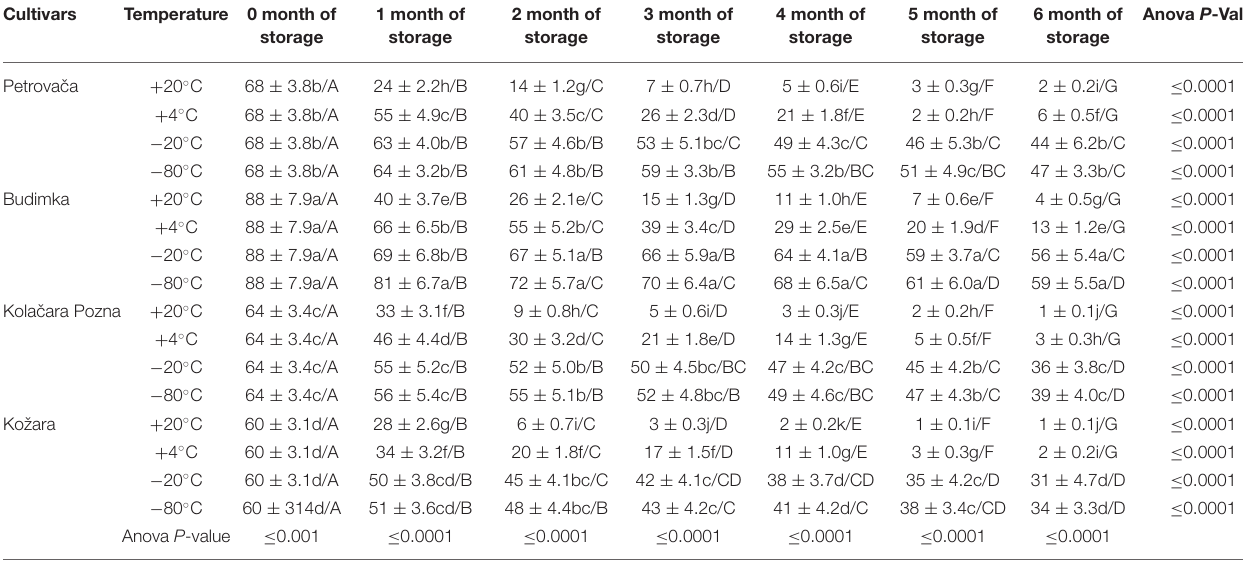
TABLE 1 | Effect of different storage temperatures and duration on in vitro pollen germination of four autochthon apple cultivars. Cultivars